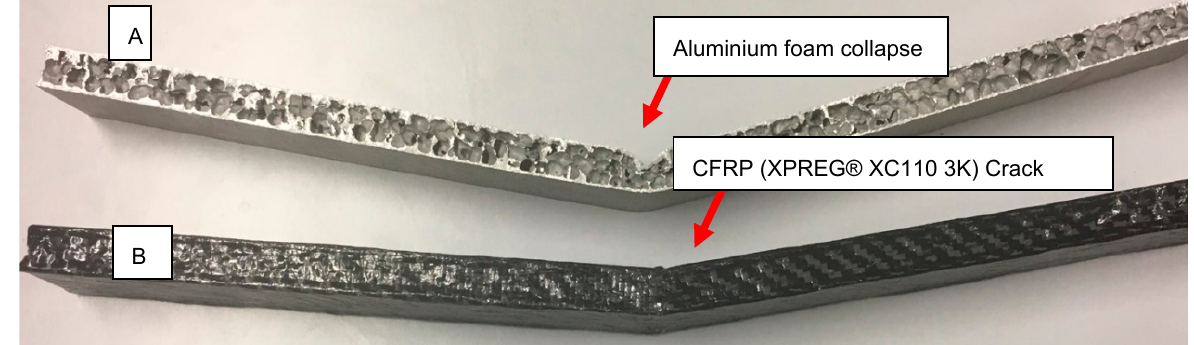
Figure 12. The shape of samples after three-point bending test; ( A ) closed-cell aluminium foam with aluminium skins; ( B ) closed-cell aluminium foam with aluminium skins wrapped around four-layers CFRP (XPREG ® XC110 3K).